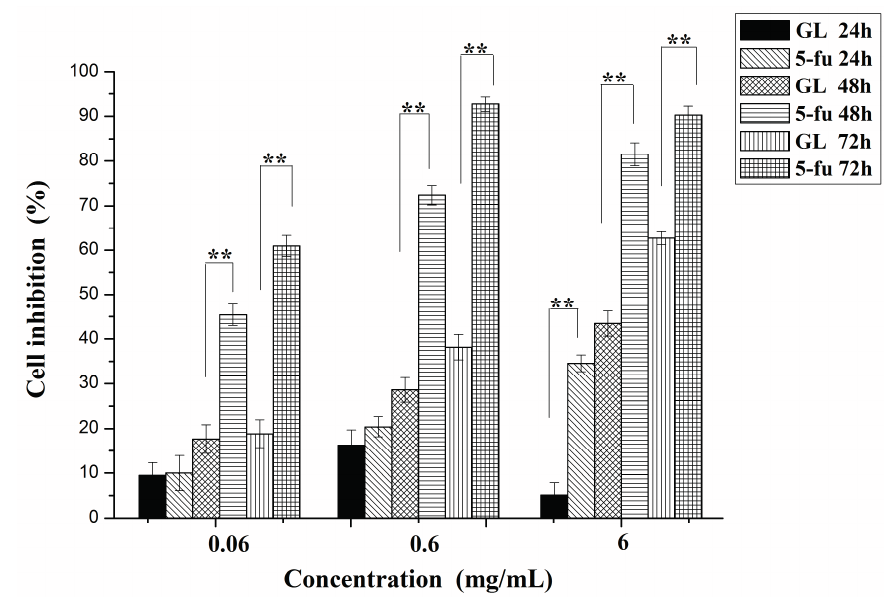
Figure 5. GL polysaccharides and 5-fu were incubated with HepG2 cells for 24, 48, and 72 h ( n = 3). ** p ˂